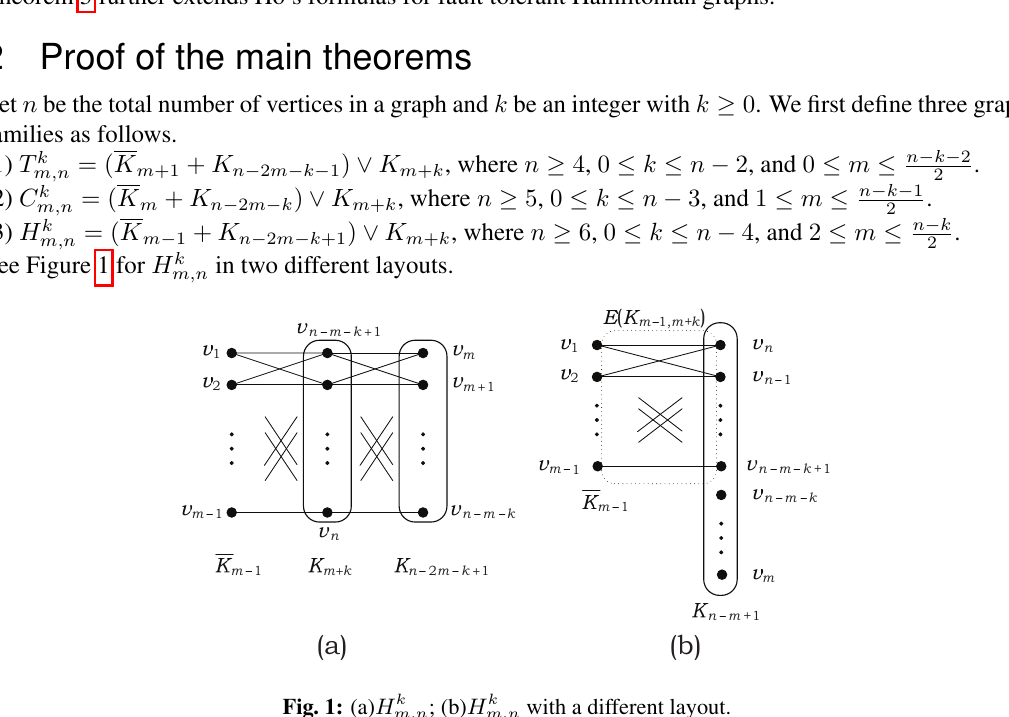
Fig. 1: (a) H k m,n ; (b) H k m,n with a different